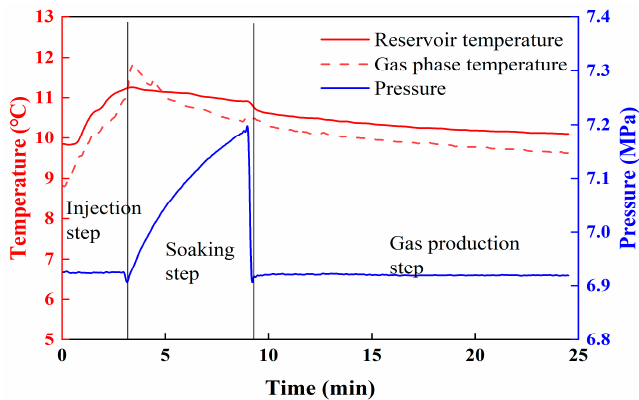
Figure 2. Typical temperature and pressure variation during gas production with an initial sediment temperature of 9 °C and pressure at 6.9 MPa.